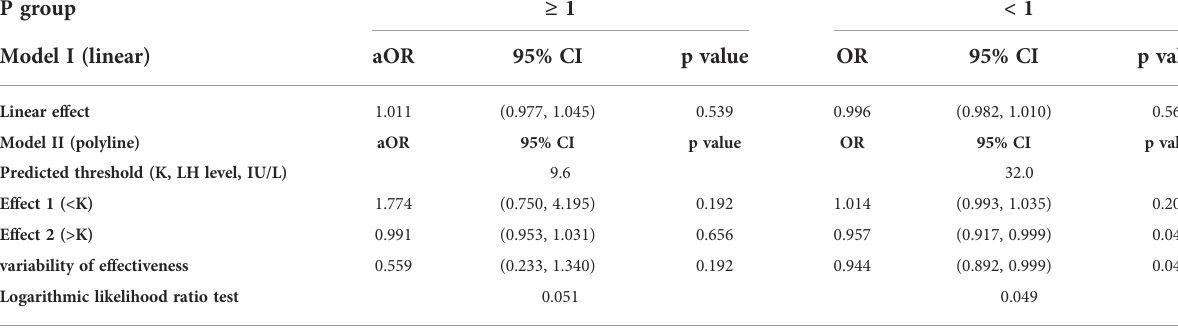
P group ≥ 1 Model I